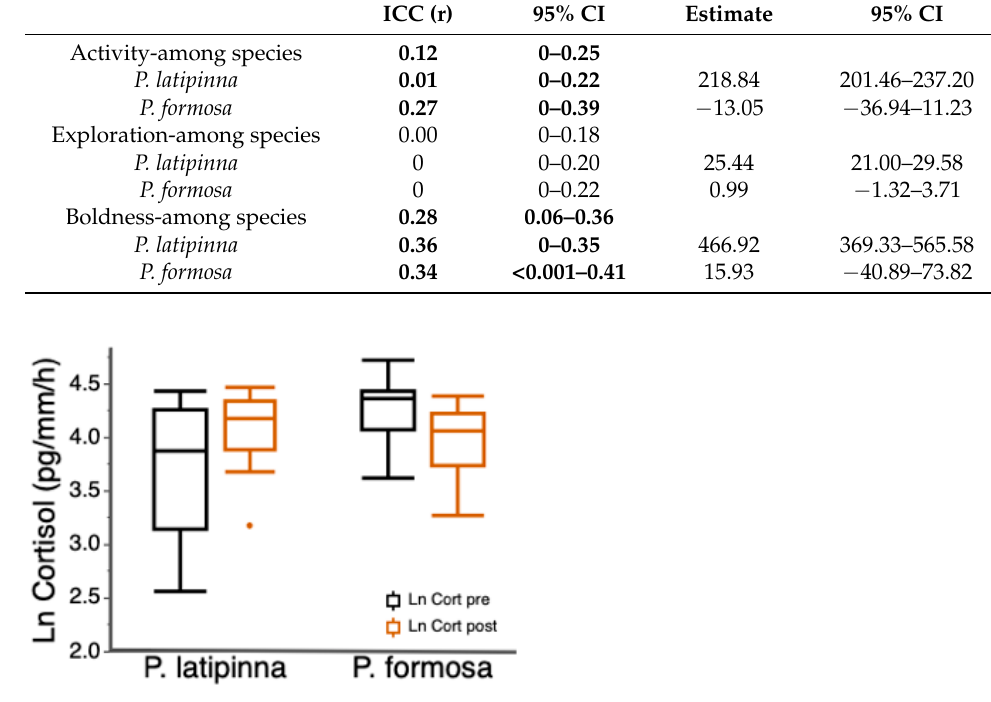
Figure 1. Mean cortisol release rate (ln pg/mm/h) for female P. latipinna and P. formosa before the behavioral trial (Pre-trial cortisol) and immediately after the behavioral trial (post-trail cortisol). Box plots indicate median, range, and first and third quartiles, dot represents an outlier.